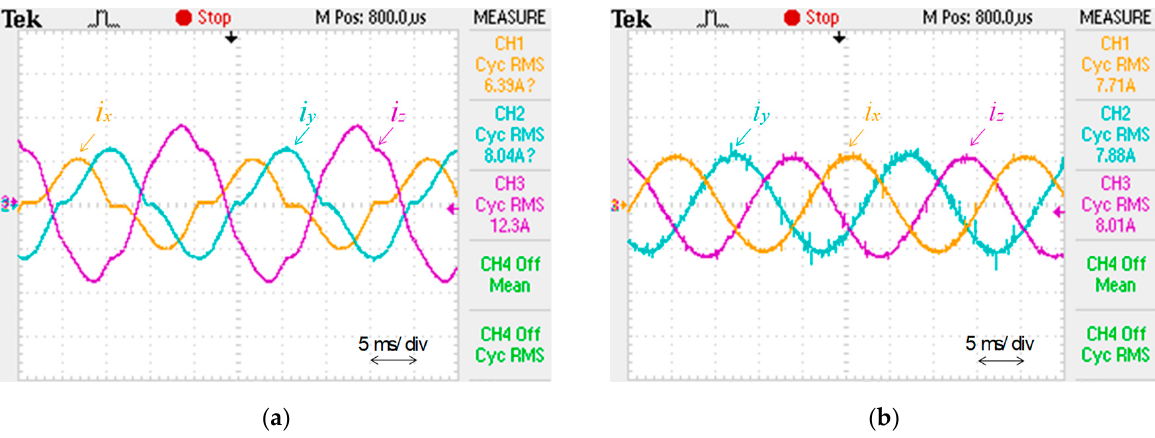
Figure 18. Experimental results when two load sections are loaded: ( a ) before compensation; ( b ) after compensation. Phase x current ( i x : 10 A/div); phase y current ( i y : 10 A/div); phase z current ( i z : 10 A/div).